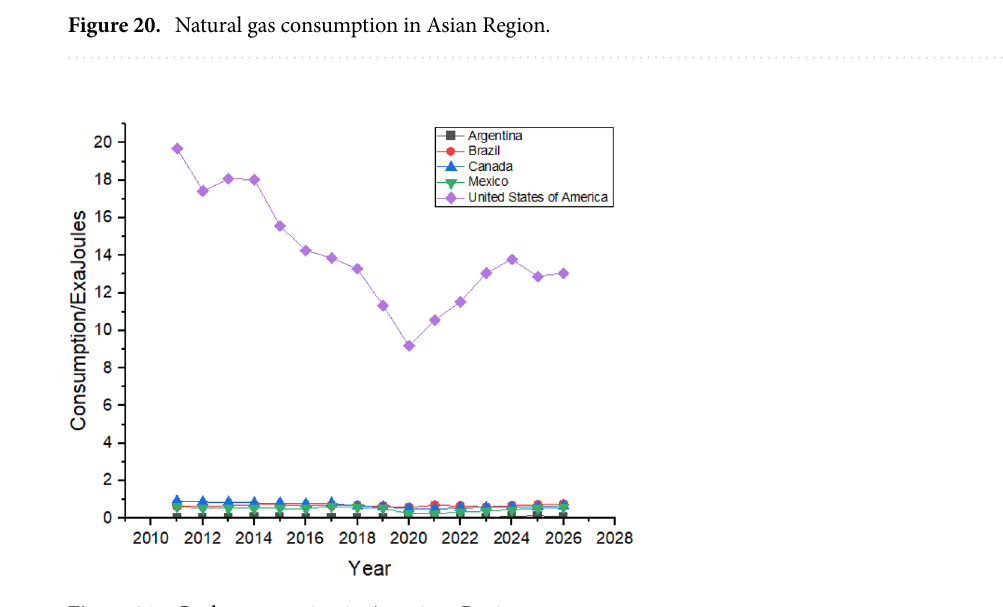
Figure 21. Coal consumption in American